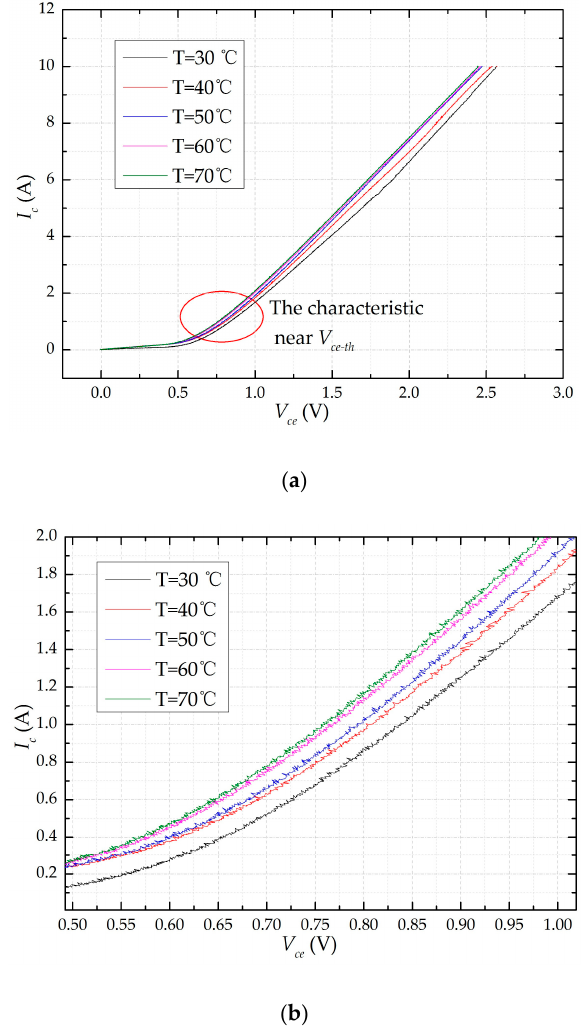
Figure 2. V–I characteristic curves at different junction temperatures: ( a ) The whole part of the characteristic curves; ( b ) the enlarged view near V ce-th .